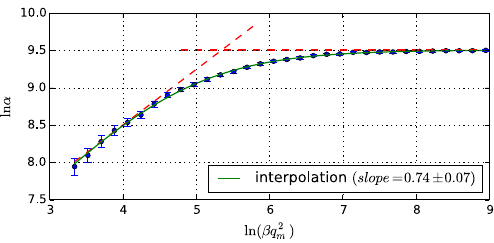
Figure 6. ln α vs ln( β q 2 m ) plot (for Q tip q e / H = 200 q 2 m , N = 36). Symbols show data with their standard deviation; solid line shows fitting. Slope of the dashed inclined line is 0 . 74